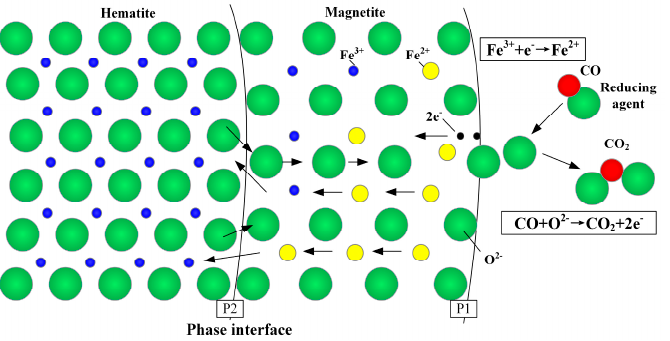
Figure 12. Atomic model for the reduction of hematite to magnetite by CO.